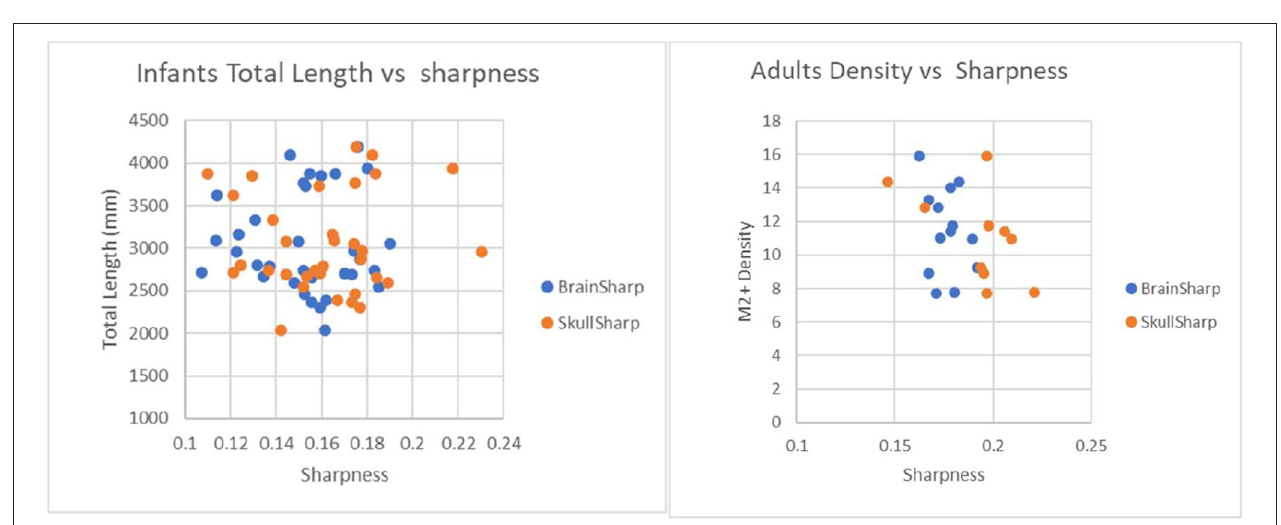
FIGURE 7 | Plot to illustrate effects of brain sharpness and skull sharpness indexes on infant and adult vascular length measurements. P -values for correlations between brain/skull sharpness indexes and total length are 0.97/0.84 for infants and 0.31/0.61 for